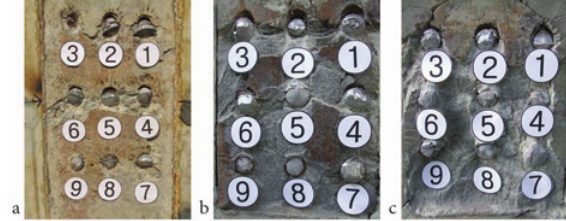
Fig. 12. Fatigue failure pattern of group stud shear connection: